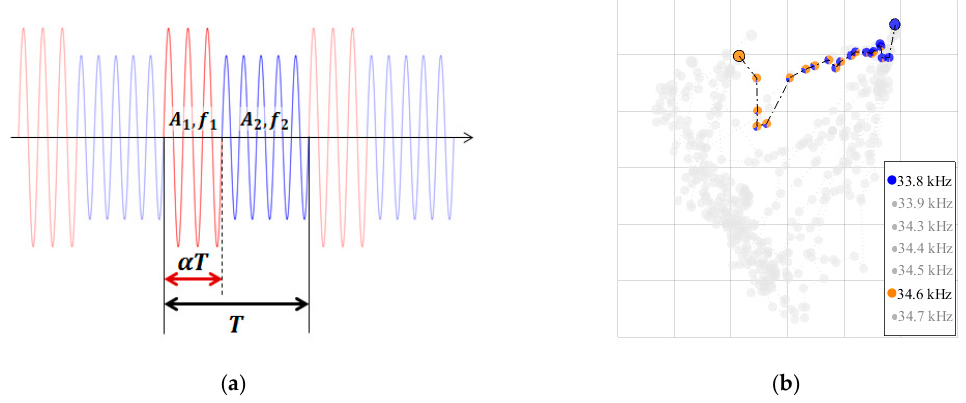
Figure 6. ( a ) Illustration of composite signal. The signal consists of a sequence of chunks with duration T . Each chunk consists of first signal (amplitude A 1 , frequency f 1 ) with duration of α T followed by second signal (amplitude A 2 , frequency f 2 ) of duration (1- α ) T . ( b ) New levitation positions created by two composite signals (33.8 and 34.6 kHz). The area of certain color (correspond to one frequency) in each pie-like marker is proportional to the duration ratio of the corresponding frequency.